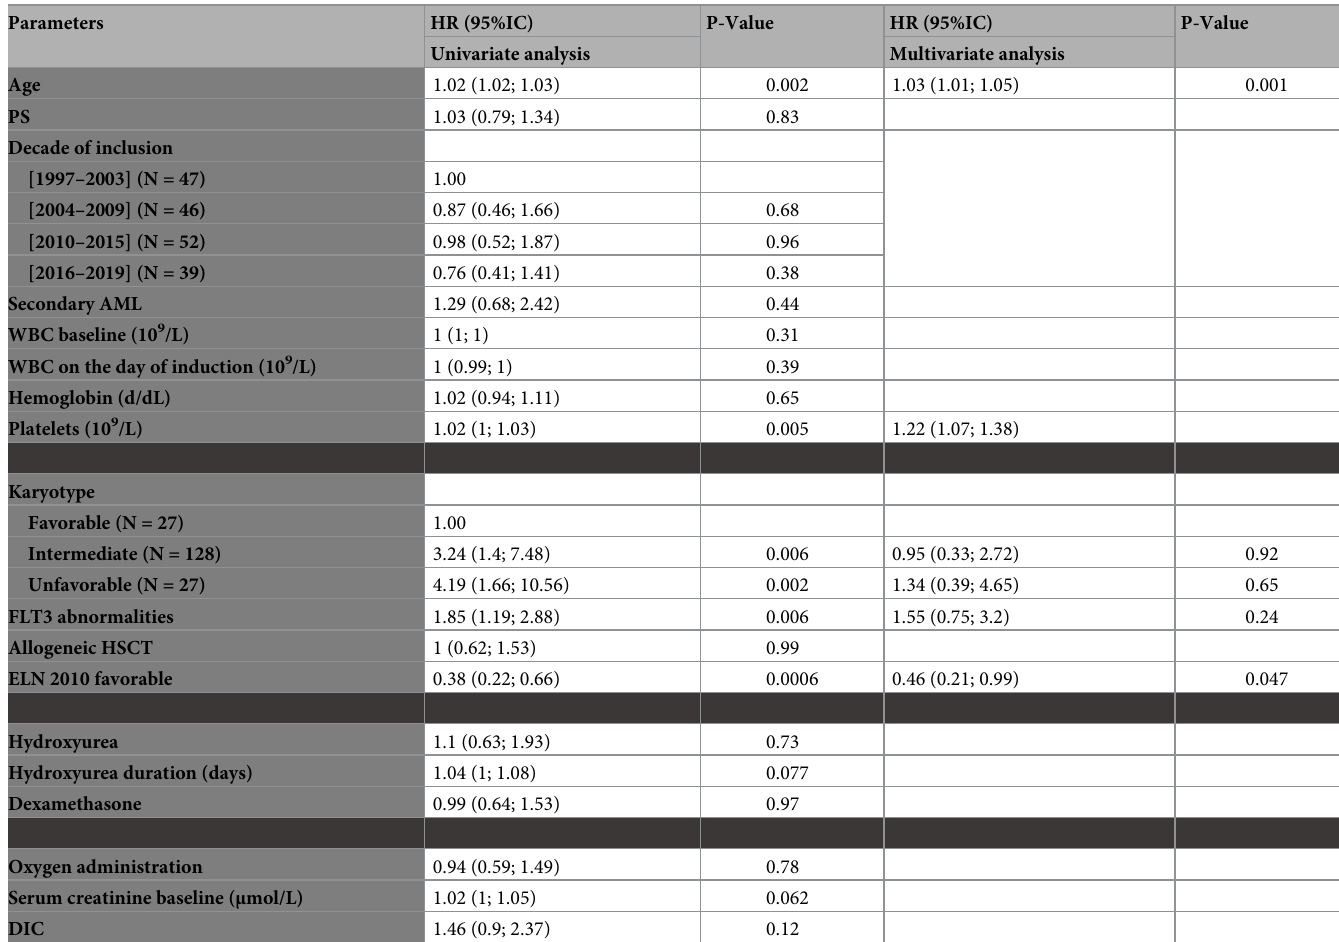
Table 4. Univariate and multivariate analysis of